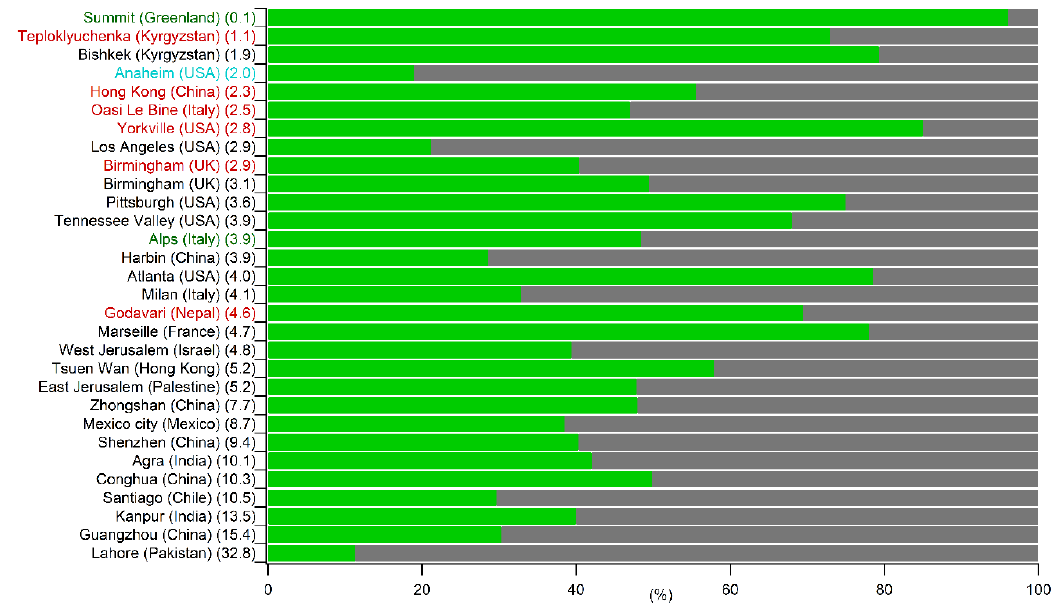
Figure 5. Spring-summer SOC (green) and POC (grey) contributions to PM 2.5 OC using CMB for all the monitored sites from 2006 to 2016. Results are presented in increasing order of OC concentration levels ( µ gC m − 3 ). In black, urban sites; in blue, suburban sites; in red, rural sites and in green, remote sites.